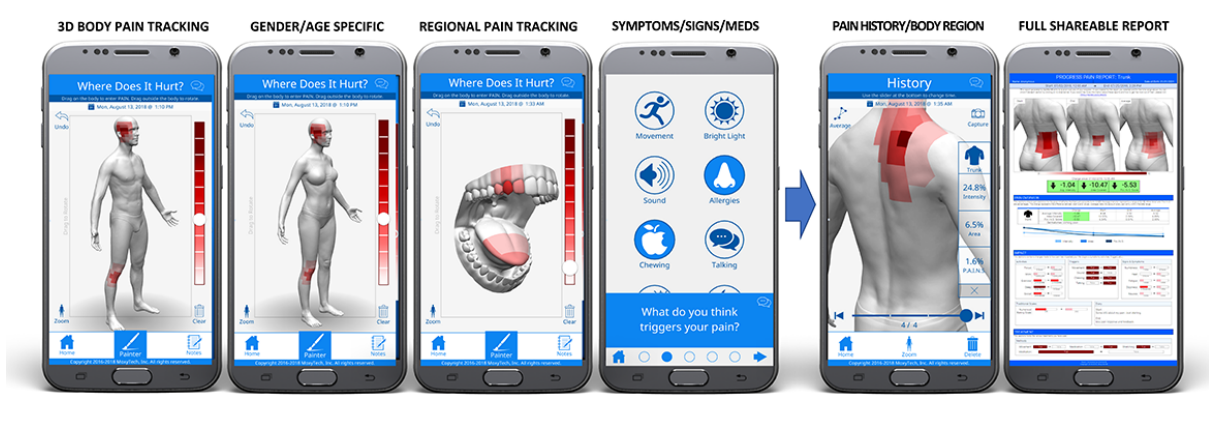
Figure 1. GeoPain tracks and measures pain in diverse single or group 3D-body models (gender and age group) and across multiple body locations. Whether the patient has TMD, migraine, fibromyalgia, or dental pain, the app can measure if a particular medication or clinical procedure is effective for each localized or spread pain condition. TMD: temporomandibular